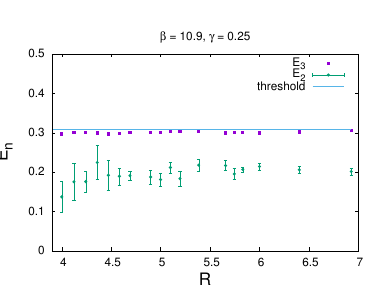
Figure 4. Ground state and excitation energies in the Landau- Ginzburg model. The ground state energy is E 1